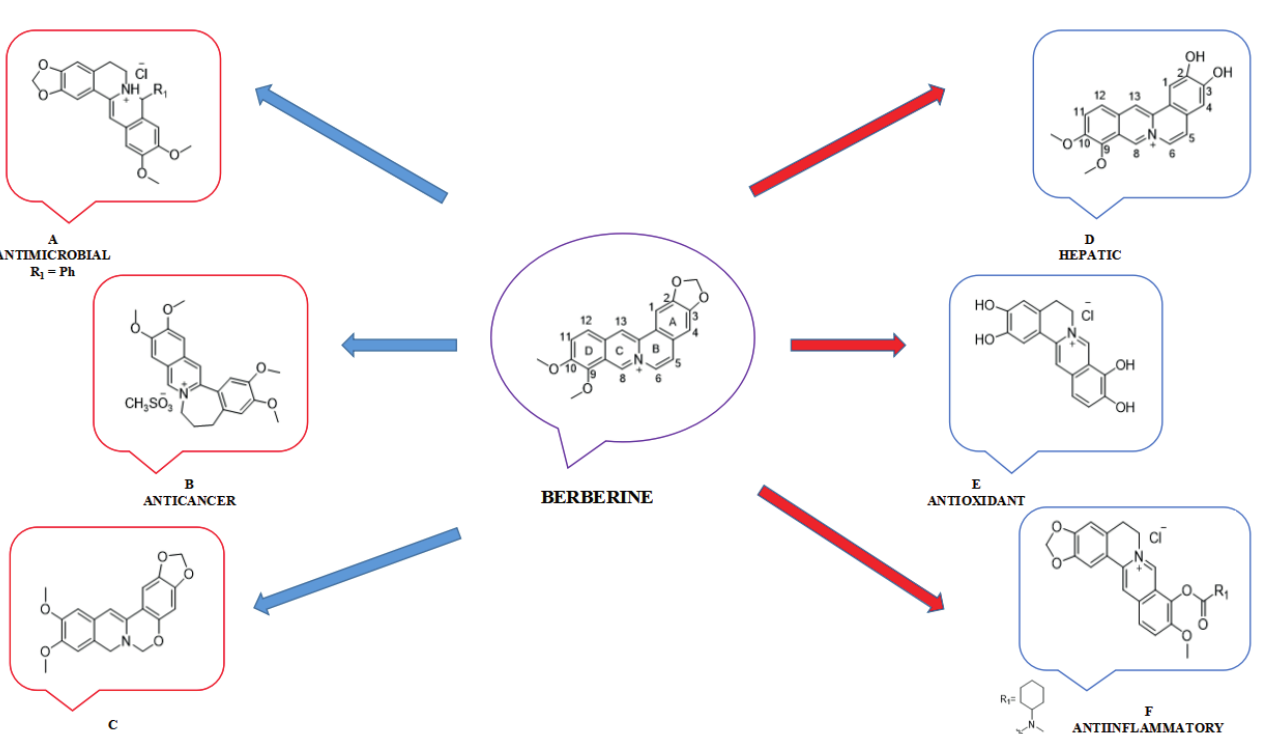
FIGURE 6 - The chemical structures and therapeutic effects of promising synthetic berberine